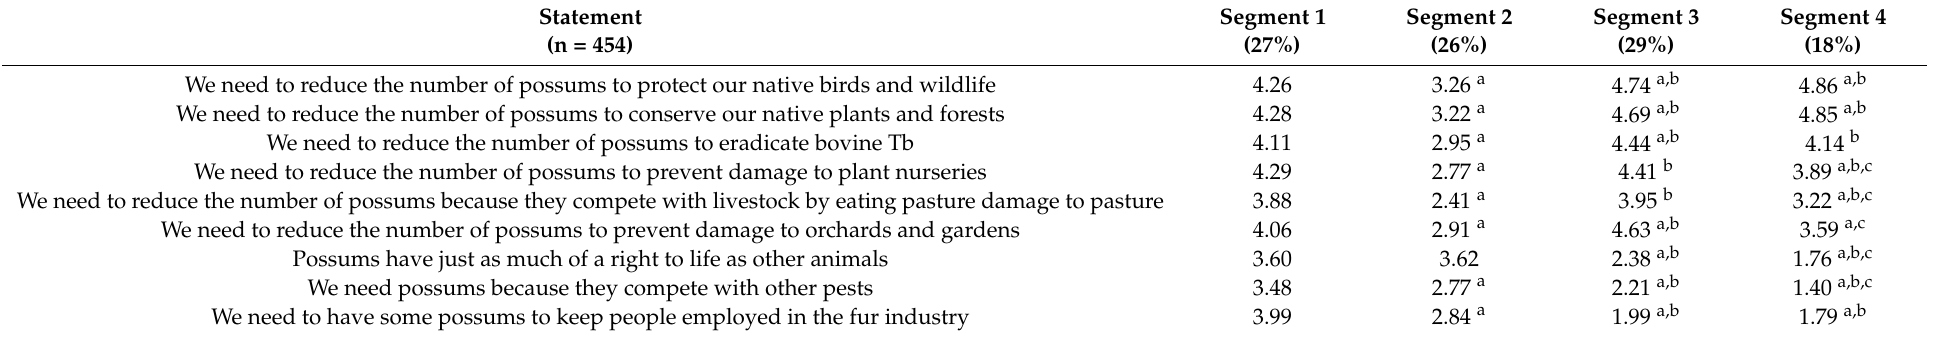
Table 2. Belief segments for reducing possum